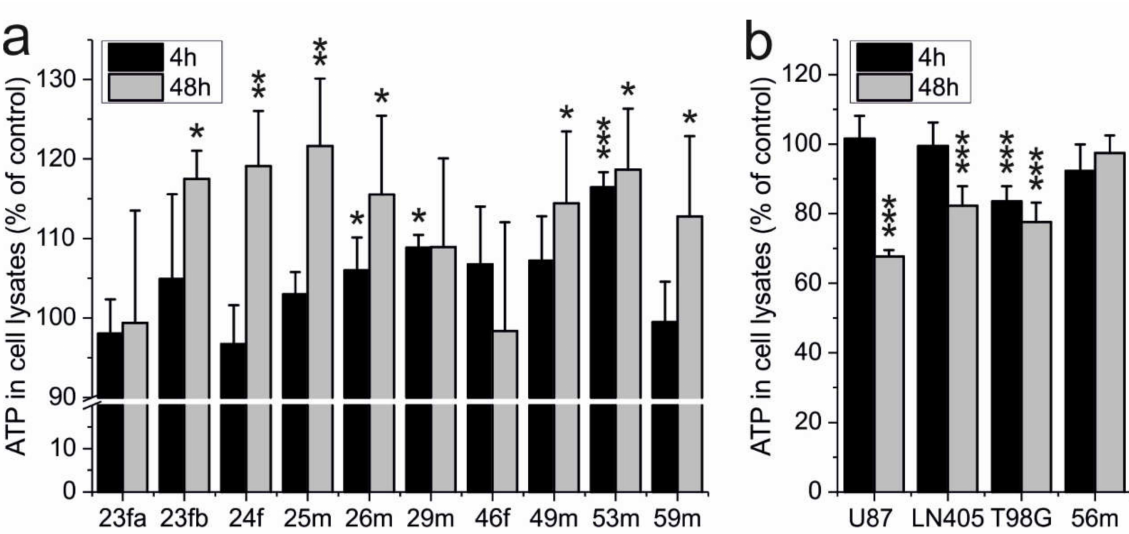
Figure 1. Effect of carnosine on ATP production in erythrocytes and glioblastoma cells. Erythrocytes (10 6 ) from ten healthy volunteers ( a ) and from three different glioblastoma cell lines (5000 cells) and erythrocytes from one healthy volunteer (10 6 ) ( b ) were incubated in DMEM2 containing carnosine (50 mM). For control, an equal number of cells from the same volunteer/cell line was incubated in the absence of the dipeptide. After 4- and 48-h incubation (black bars/grey bars, respectively), viability was determined by measuring the amount of ATP in cell lysates. Shown is the amount of ATP in cell lysates from cells treated with carnosine that was normalized to that of corresponding control cells without carnosine, set to 100%. All measurements were performed in sextuplicate; statistical significance was performed by Welch’s t-test (0 vs. 50 mM carnosine): *: p < 0.05; **: p < 0.005; ***: p < 0.0005. Volunteer’s age and sex have been used to indicate the individual samples (f: female; m: